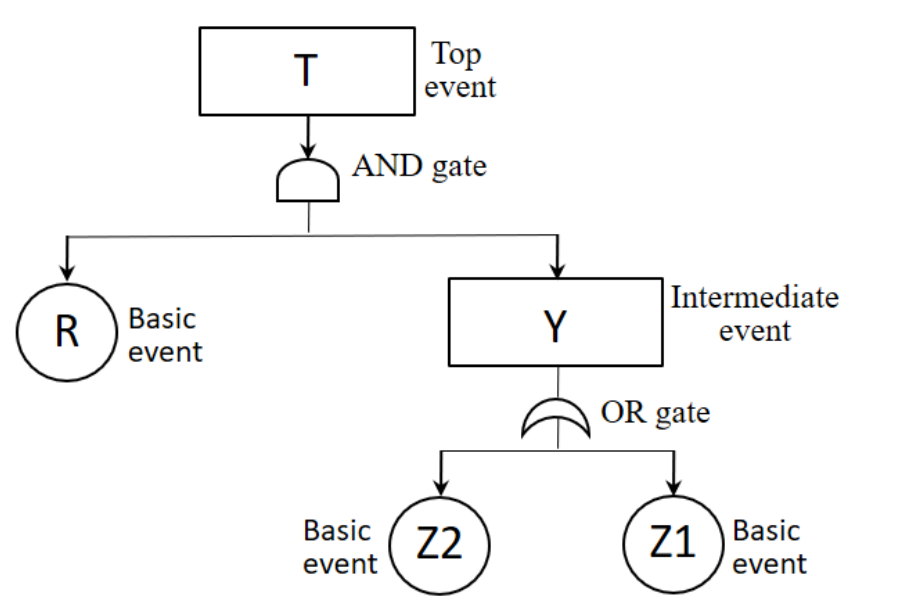
Figure 5. Structure of a fault tree.